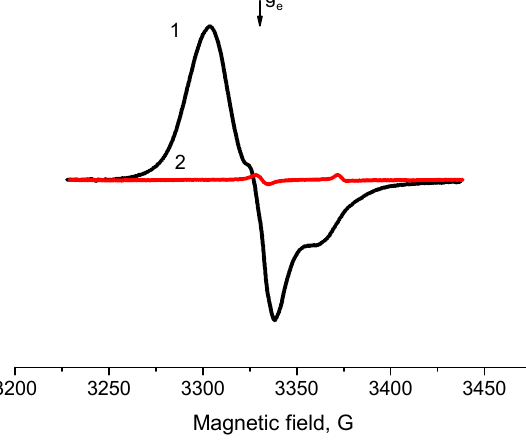
Figure 12. EPR spectra of TNB radical anions adsorbed on 2% Pd/ZrO 2 ( 1 ) and sulfated 2% Pd/ZrO 2 catalyst ( 2 ). T act = 500 °C.